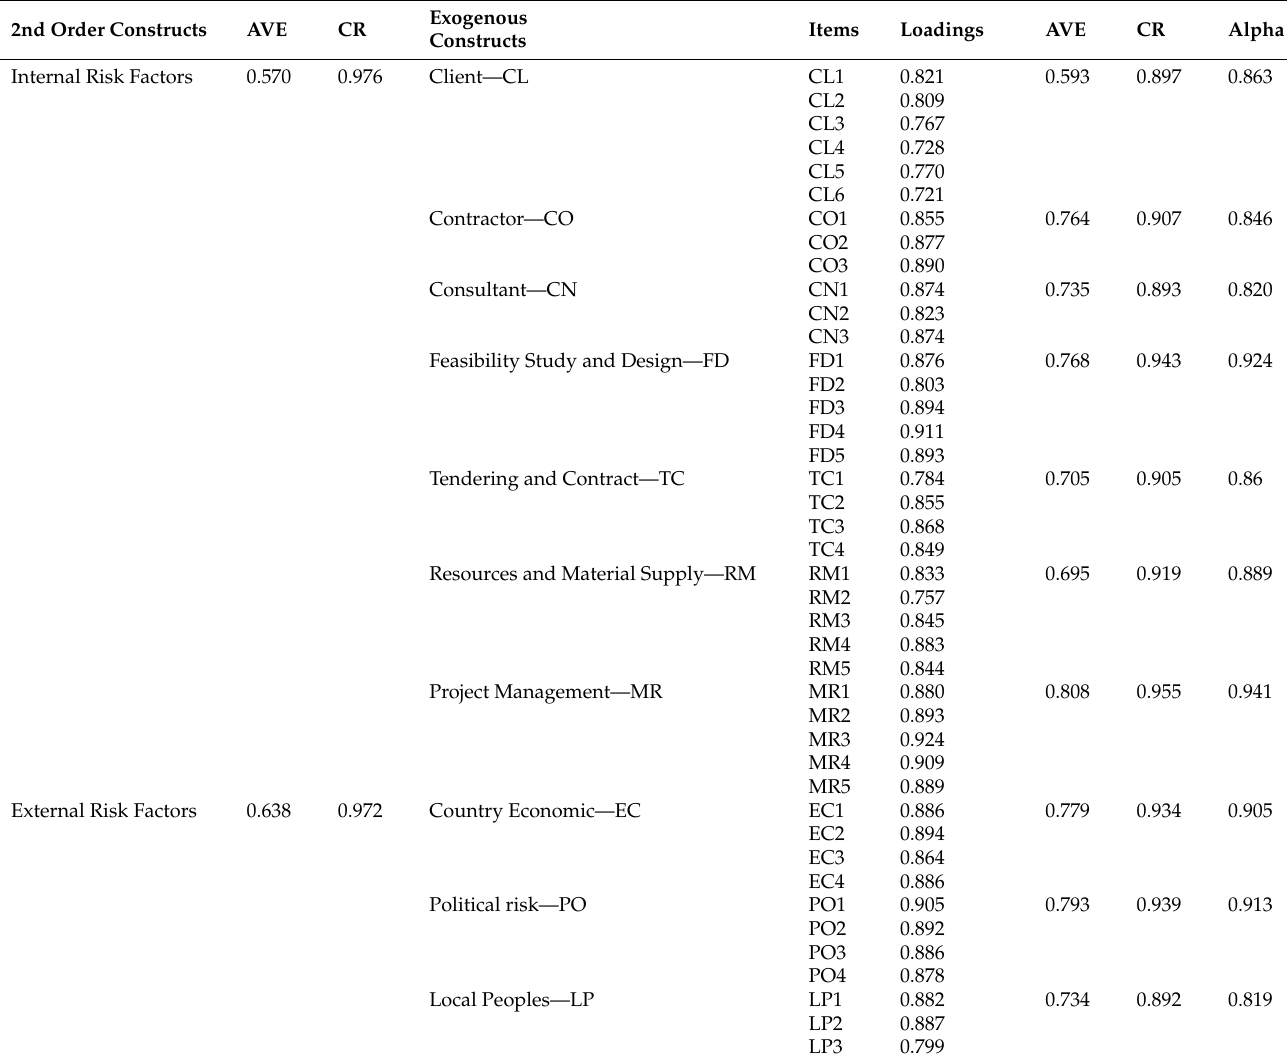
Table 8. Results of measurements model—Convergent